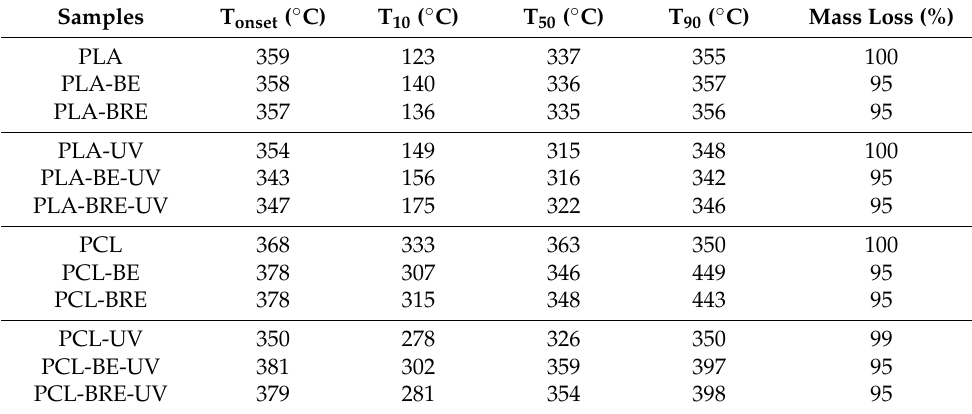
Table 3. Summary of TGA curves for the PLA, PCL, and composites.